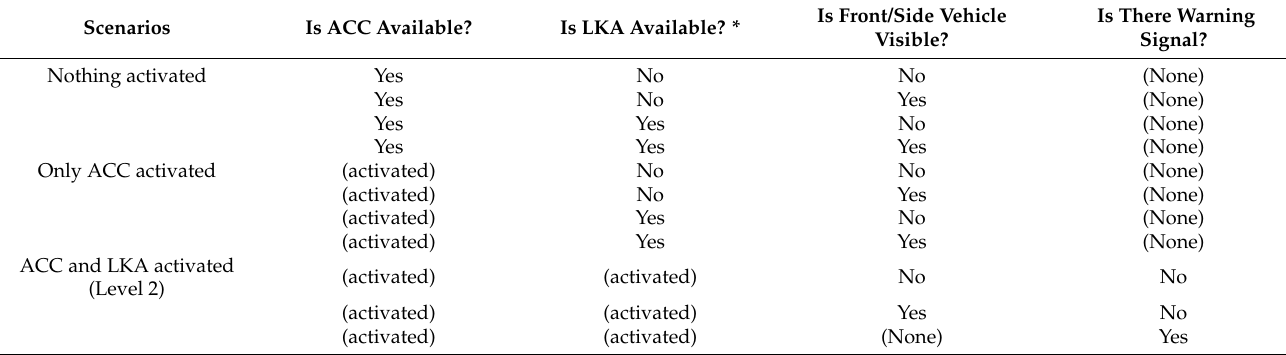
Table 1. HMI scenarios under different